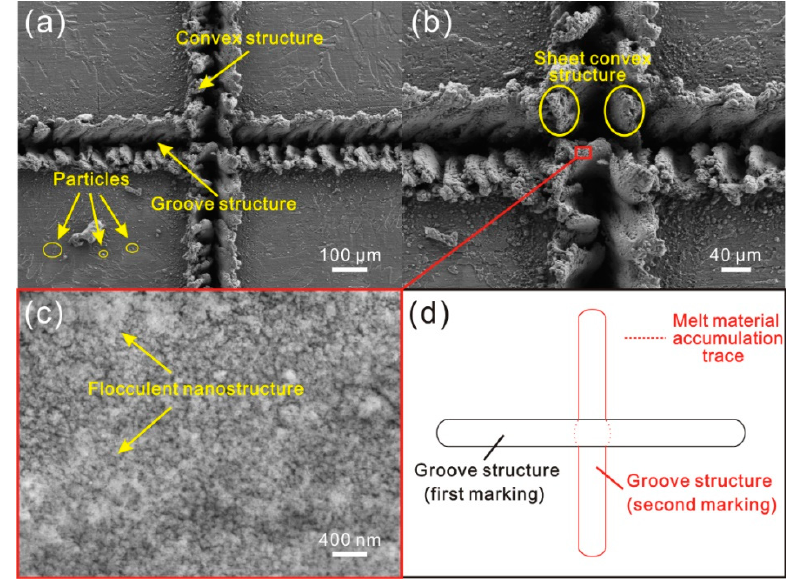
Figure 6. ( a ) SEM image of cross microstructure on Al alloy surface (laser beam pulse frequency of 6000 Hz, laser beam scanning speed of 0.15 m/s); ( b , c ) high-magnification SEM image of the microstructure; ( d ) schematic of the preparation process of cross structure.